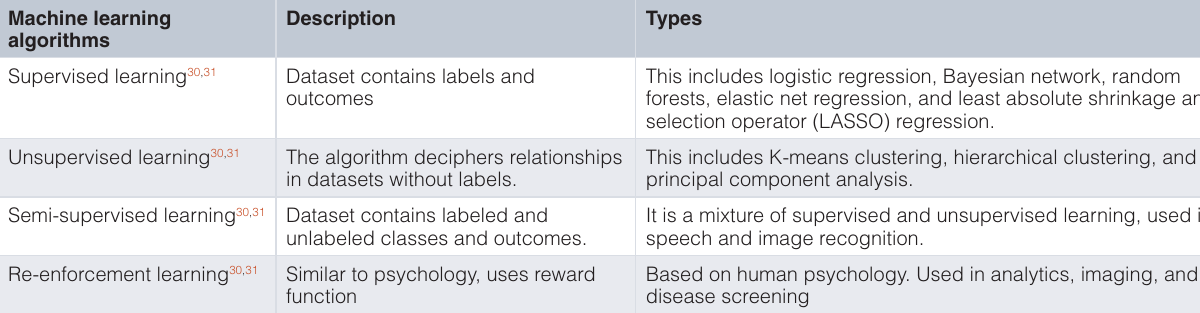
Table 2. Types of machine